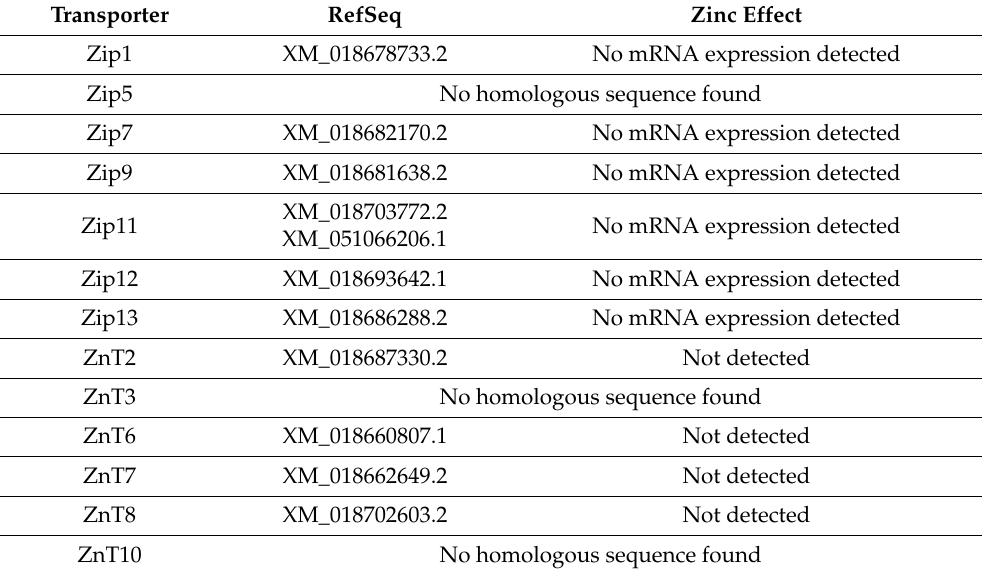
Figure 3. SF cells were cultured in CHELEX-treated medium, zinc adequate (ZA) medium or me- dium supplemented with zinc (50 µM) for 7 days. Afterwards mRNA was isolated, used for meas- uring expression of ZnT1 ( a ), ZnT4 ( b ), ZnT5 ( c ) and ZnT9 ( d ) mRNA expression and normalized to EF1A mRNA. Mean values + SEM of n = 7 independent experiments are shown. Significantly